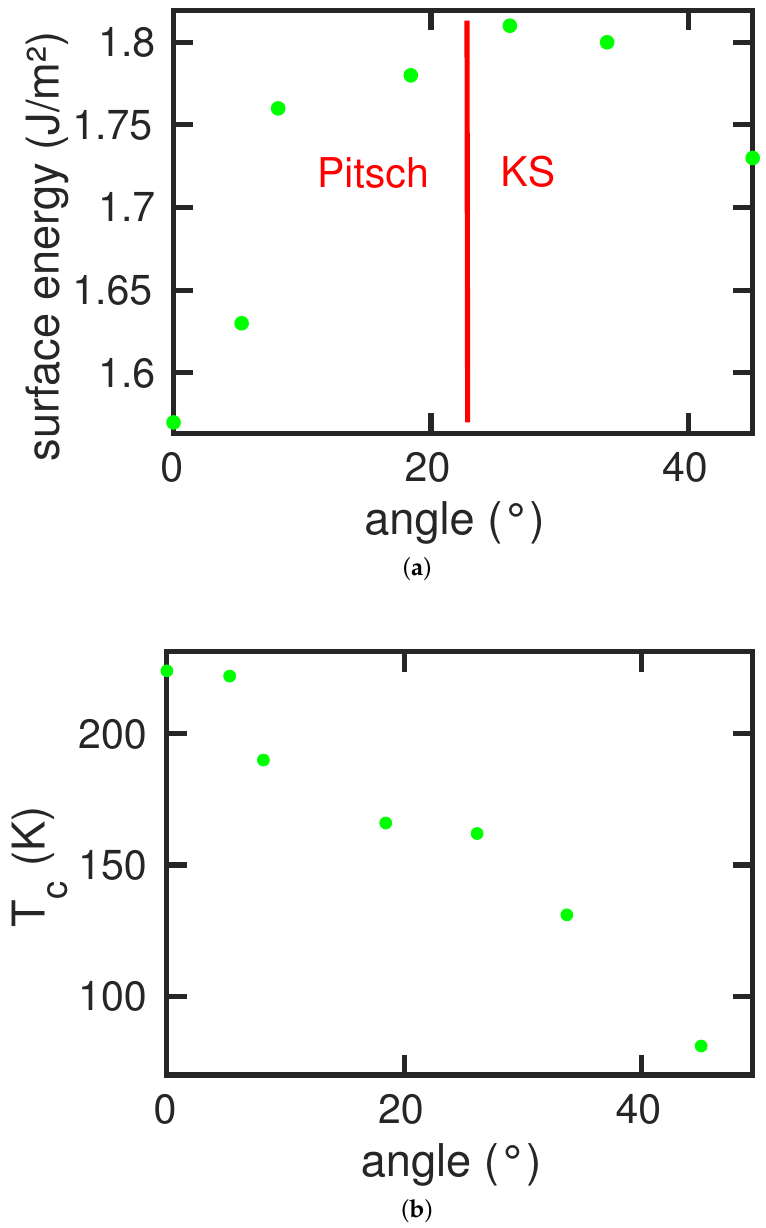
Figure 9. Dependence of the fcc specific surface energy ( a ) l and the transition temperature of the martensitic phase transition T c ( b ) on the tilt angle φ . The red line in ( a ) separates the regions where the Pitsch and the Kurdjumov–Sachs (KS) paths are